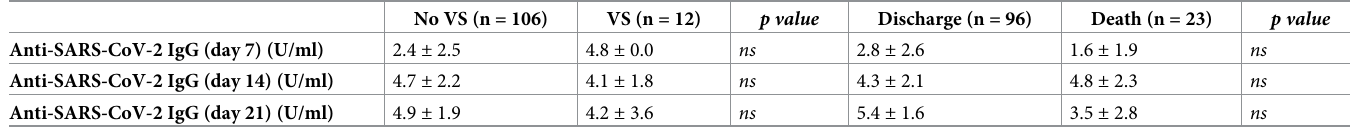
Table 6. Anti-SARS-CoV-2 IgG antibodies levels in patients who presented unfavorable outcomes (VS and death) and in those who did